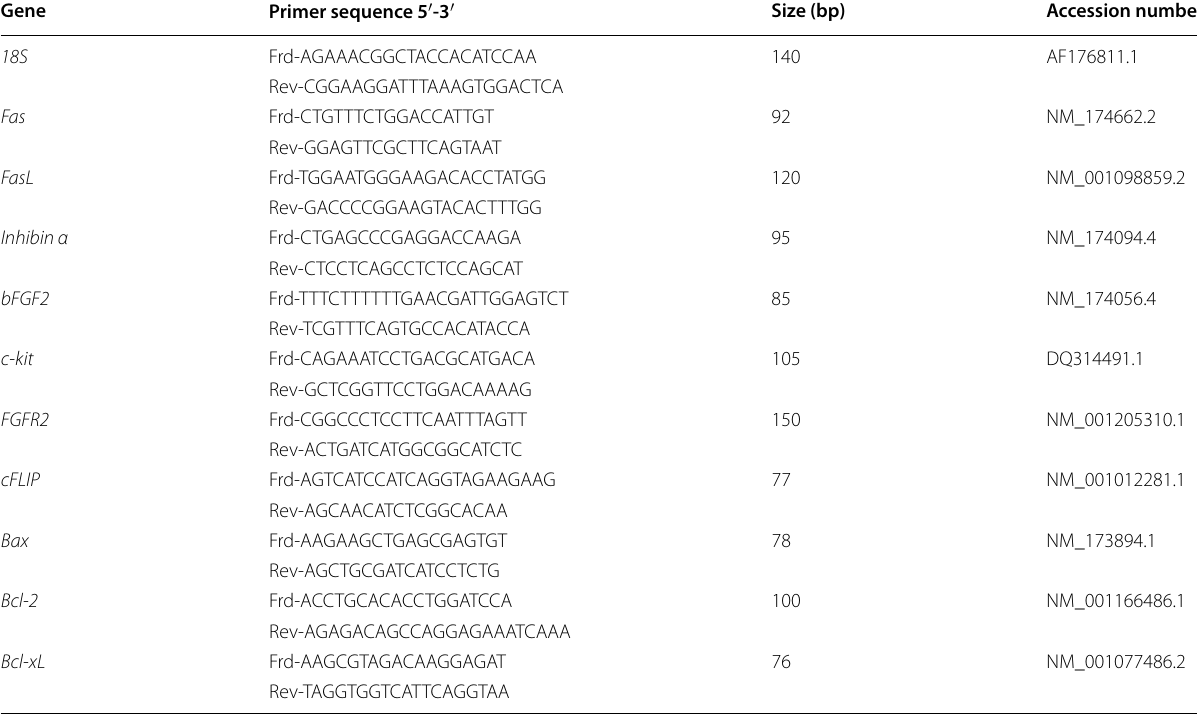
Table 1 Oligonucleotide primer sequences and amplicon size used for real-time